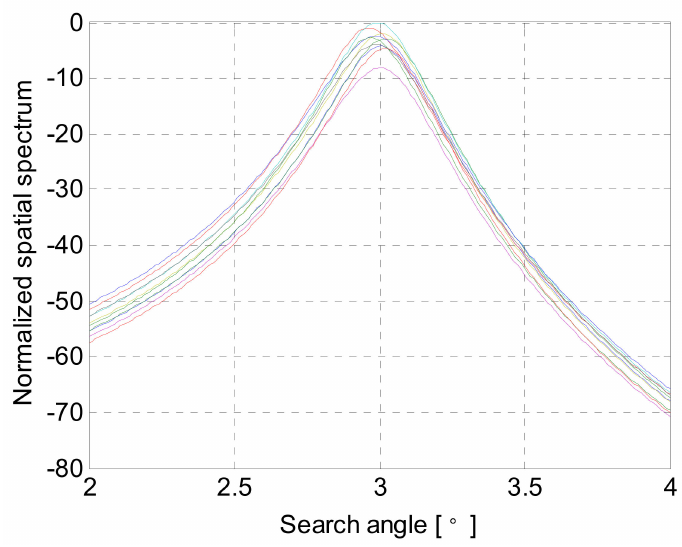
Figure 2. The spatial spectrum of the proposed algorithm with 10 times.